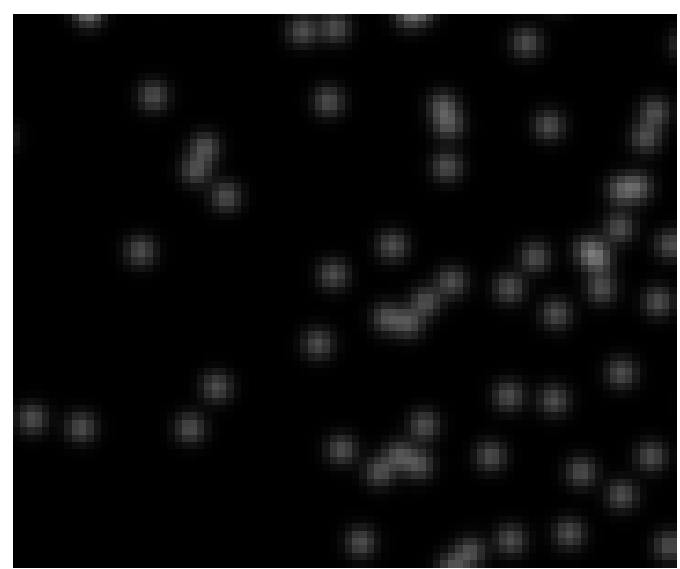
Figure 2. Artificially generated measurement image (a fraction of 75 × 90px of the full image with 1024 × 1280px). The intensity of each particle is Gaussian distributed around its projected